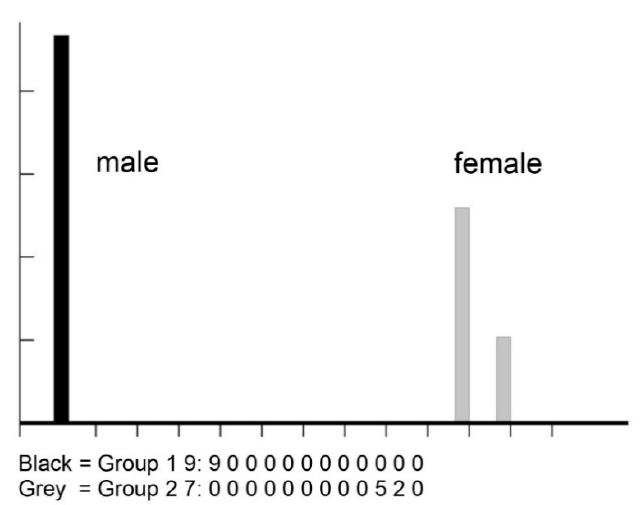
Figure 7. Factor map of the discriminant factor separating males (black bar) and females (grey bar) of Haematobosca aberrans Pont, Duvallet & Changbunjong, 2020.